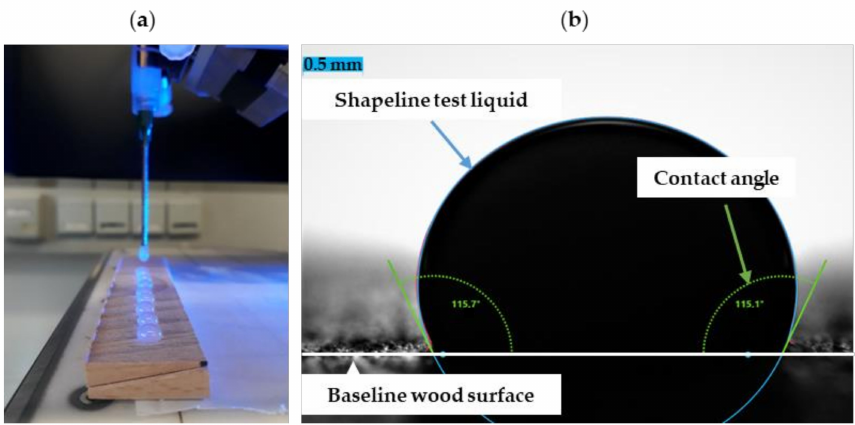
Figure 4. Application of adhesive on a freshly processed wood surface in the tangential direction ( a ) and contact angle measurement by the sessile-drop method, ( b ) shows the contour of an adhesive droplet after application to the wood surface and the calculated contact angle using the ADVANCE robust fitting algorithm, according to Krüss GmbH software-based range of the contact angle is 0 to 180 ◦ and resolution is 0.01 ◦